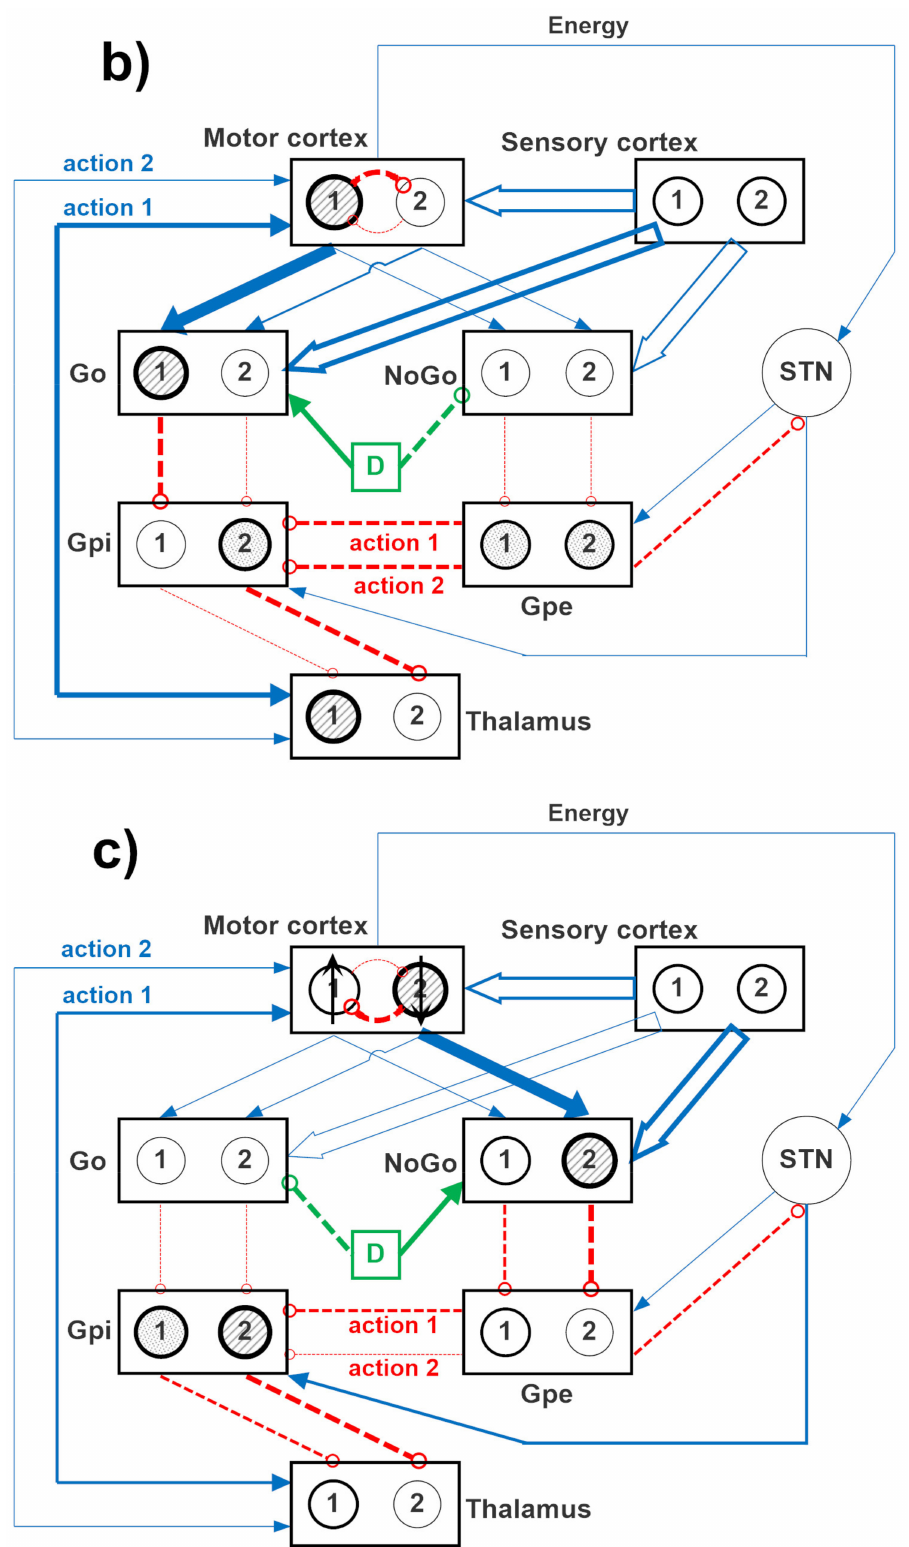
Figure 12. ( a ) Schematic diagram of the BG computational model where two action channels are used. Continuous blue lines represent excitatory synapses, while red dashed lines represent inhibitory synapses. Single lines indicate that the synapse is represented by a scalar parameter, one per